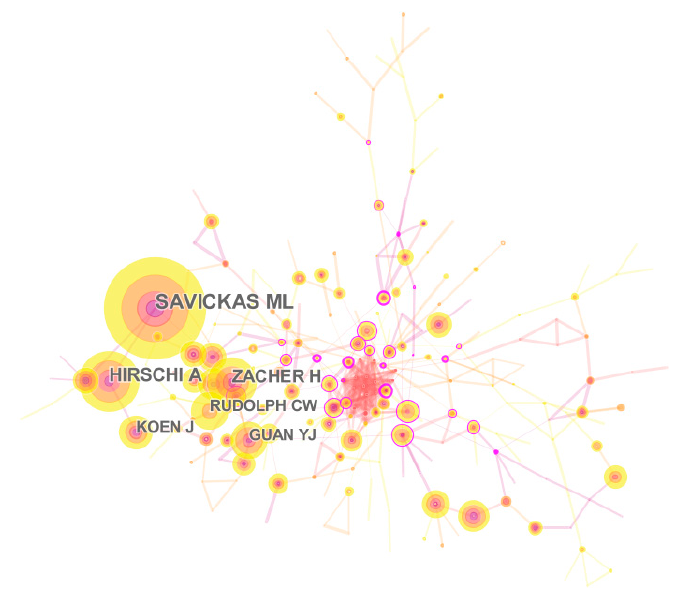
Figure 2. Co-cited atlas of career adaptability authors.